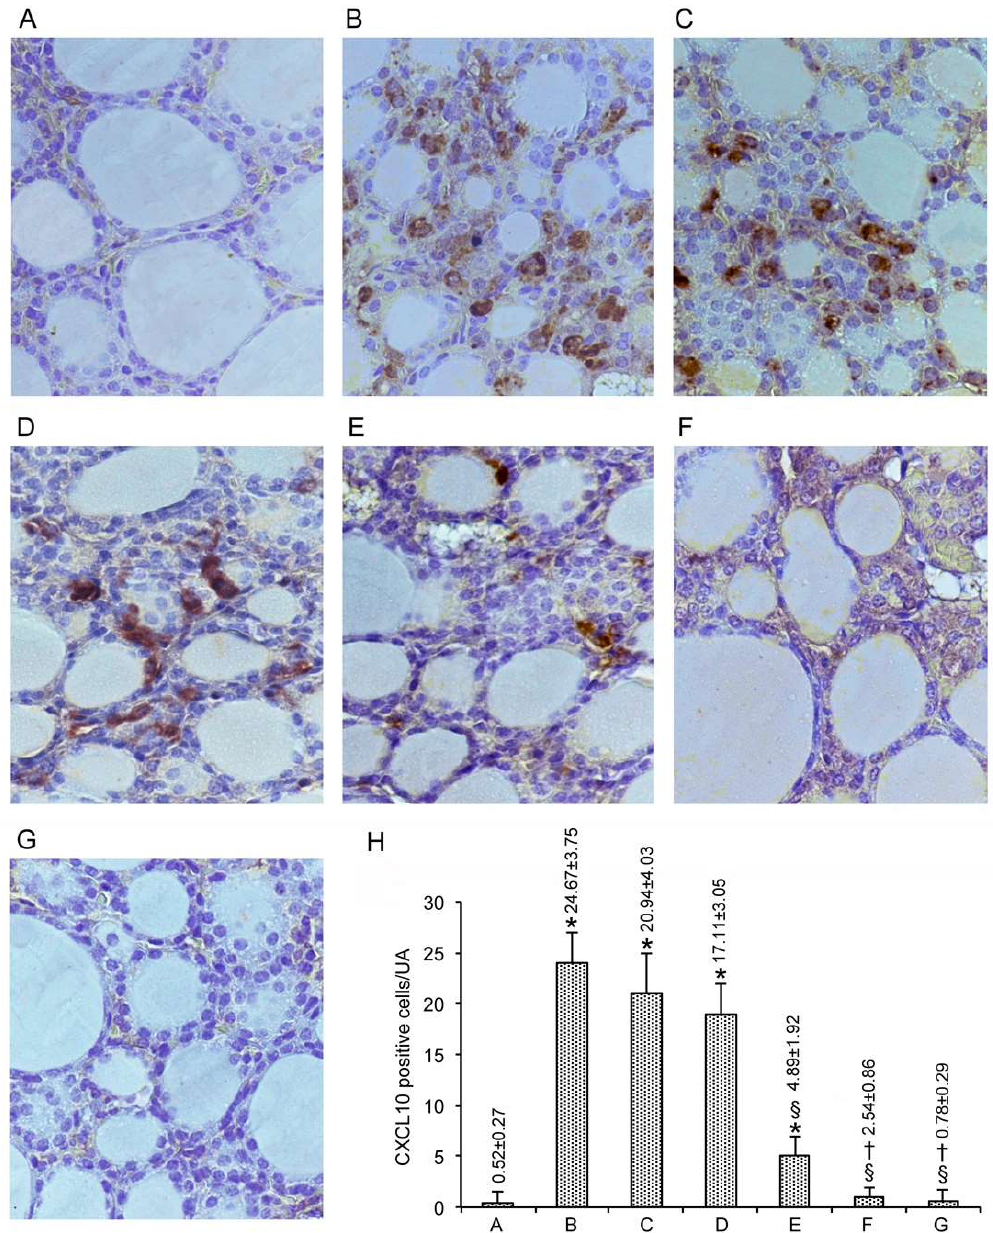
Figure 4. Immunohistochemical expression of C-X-C motif chemokine 10 (CXCL10) in the thyroid (scale bar: 25 μm). Mice groups are as in Figure 1. ( A ): In controls, no CXCL10-positive cells are evident, as shown by bar A in H. ( B ): In CdCl 2 -treated mice, a large number of CXCL10-positive cells is present among the follicle walls, as indicated by bar B in H. ( C-D ): In mice treated with CdCl 2 plus 0.2 mg/kg Se or CdCl 2 plus 0.4 mg/kg Se, the number of CXCL10-positive cells is decreased, but still high, as evidenced by bars C and D in H. ( E ): In CdCl 2 plus MI-treated mice, only a few CXCL10-positive cells are present, as shown by bar E in H. ( F-G ): In the thyroid of CdCl 2 plus MI and 0.2 mg/kg Se or CdCl 2 plus MI and 0.4 mg/kg Se, no CXCL10 immunoreactivity is detectable, as indicated by bars F-G in H. ( H ) : The number of CXCL10-positive cells per microscopic field in the different groups of mice (mean ± standard error).* p < 0.05 versus control; § p < 0.05 versus CdCl 2 plus vehicle and CdCl 2 plus Se 0.2 or 0.4 mg/kg Se; † p < 0.05 versus CdCl 2 plus MI.